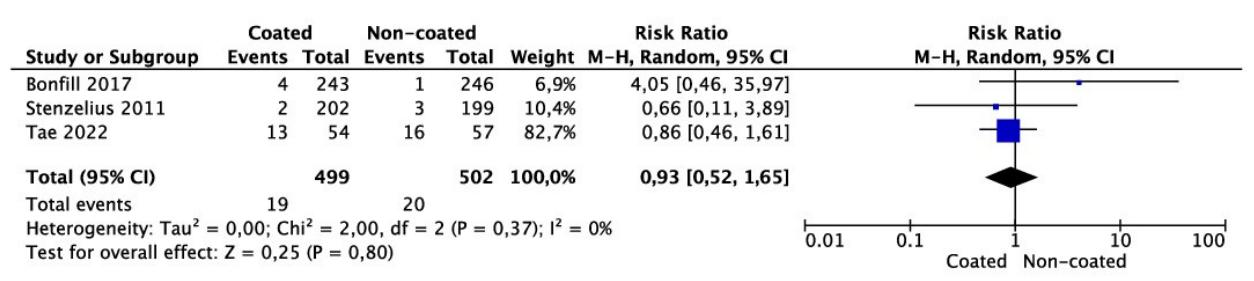
Figure 4. Meta-analysis of need for removal/change of catheter.